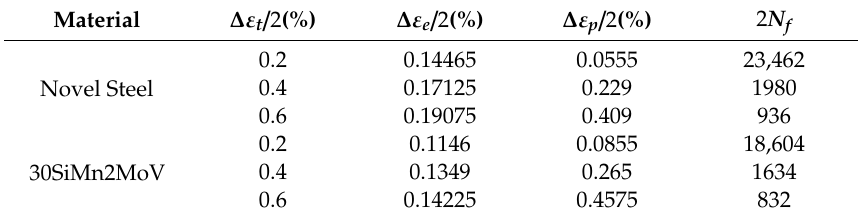
Figure 8. The superimposed hysteresis loops along the linear portion to match upper branches ( a ) novel steel and ( b ) 30SiMn2MoV.